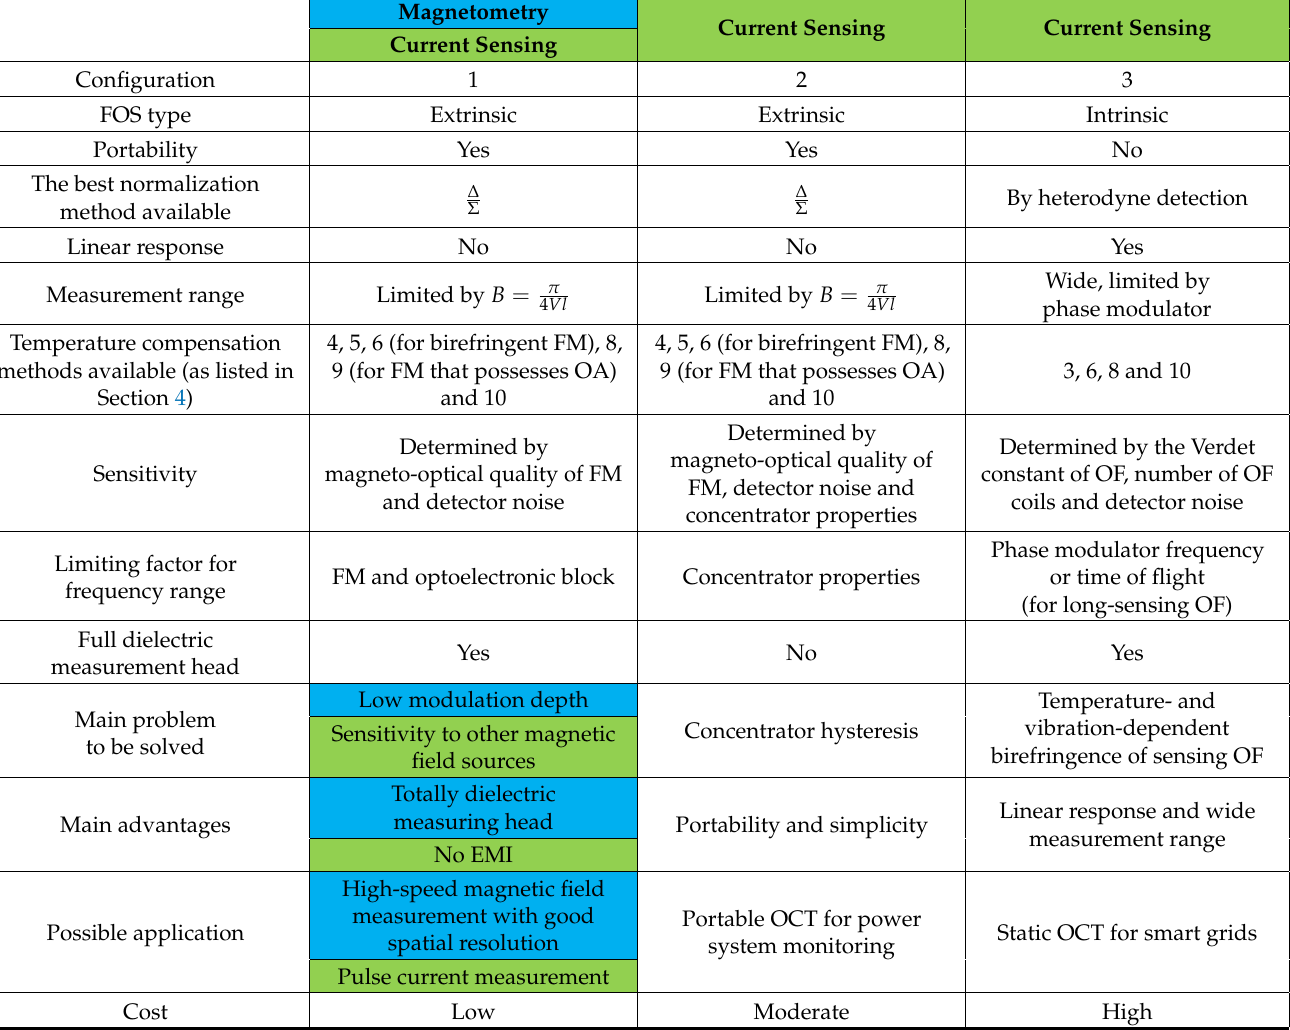
Table 3. Comparison of three FOS